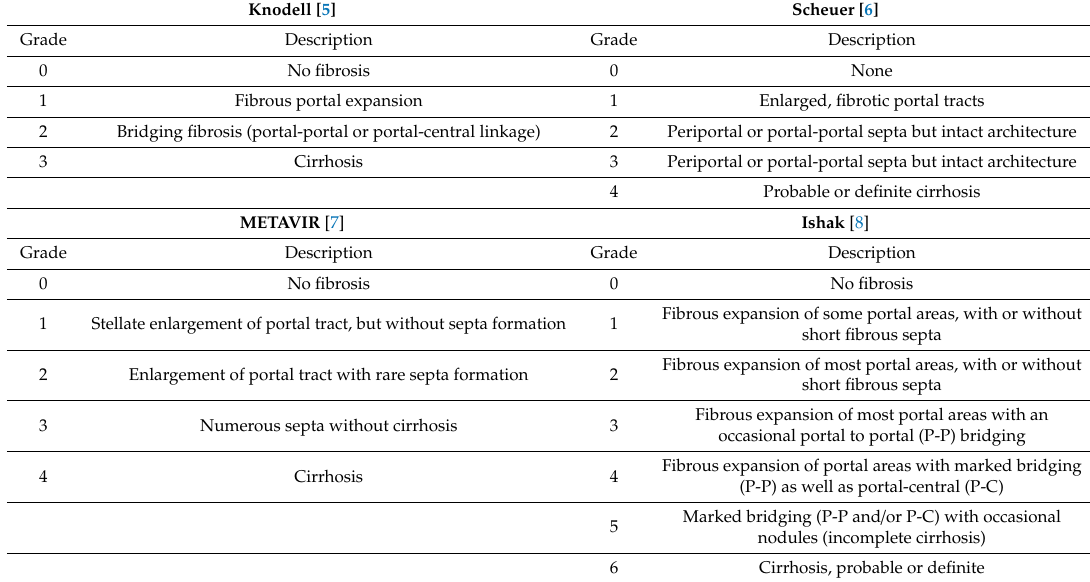
Table 1. Histology activity indexes (HAIs) as scoring systems for fibrosis and cirrhosis grading.